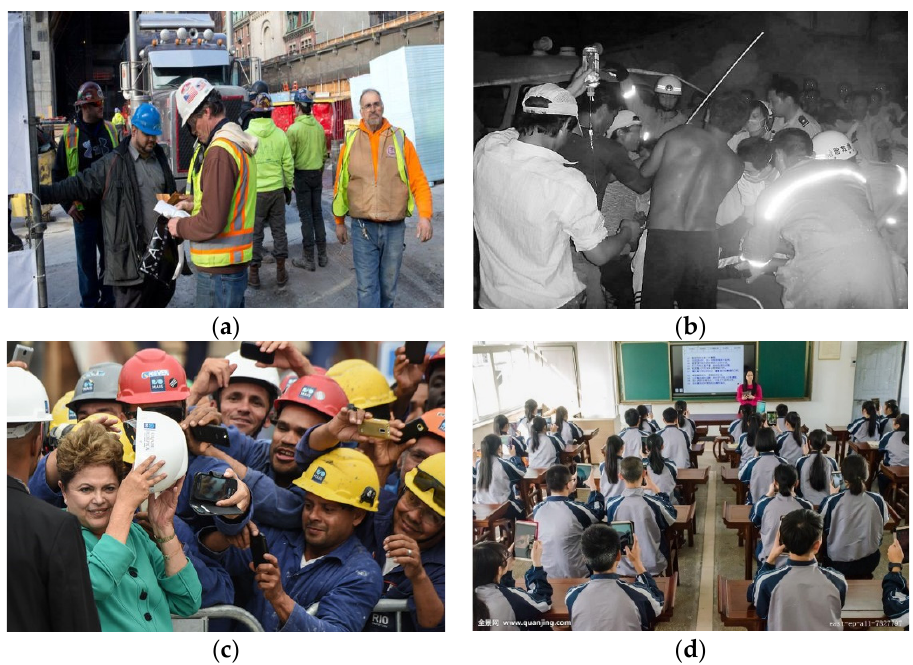
Figure 3. Four different test scenarios with helmets. ( a ) including positive and negative samples; ( b ) dark samples; ( c ) object occlusion; ( d ) negative samples. ( b ) dark samples; ( c ) object occlusion; ( d ) negative samples.